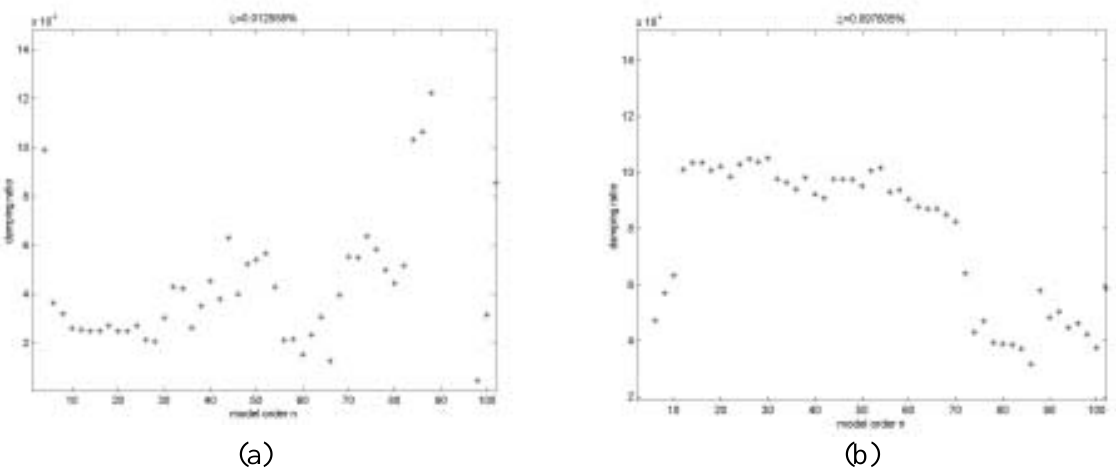
Fig. 3. CVA on the signal of Fig. 1. (a) Damping stabilisation diagram for the pure tone at f = 0 . 0625 . (b) Damping stabilisation diagram for the resonance at f = 0 . 35